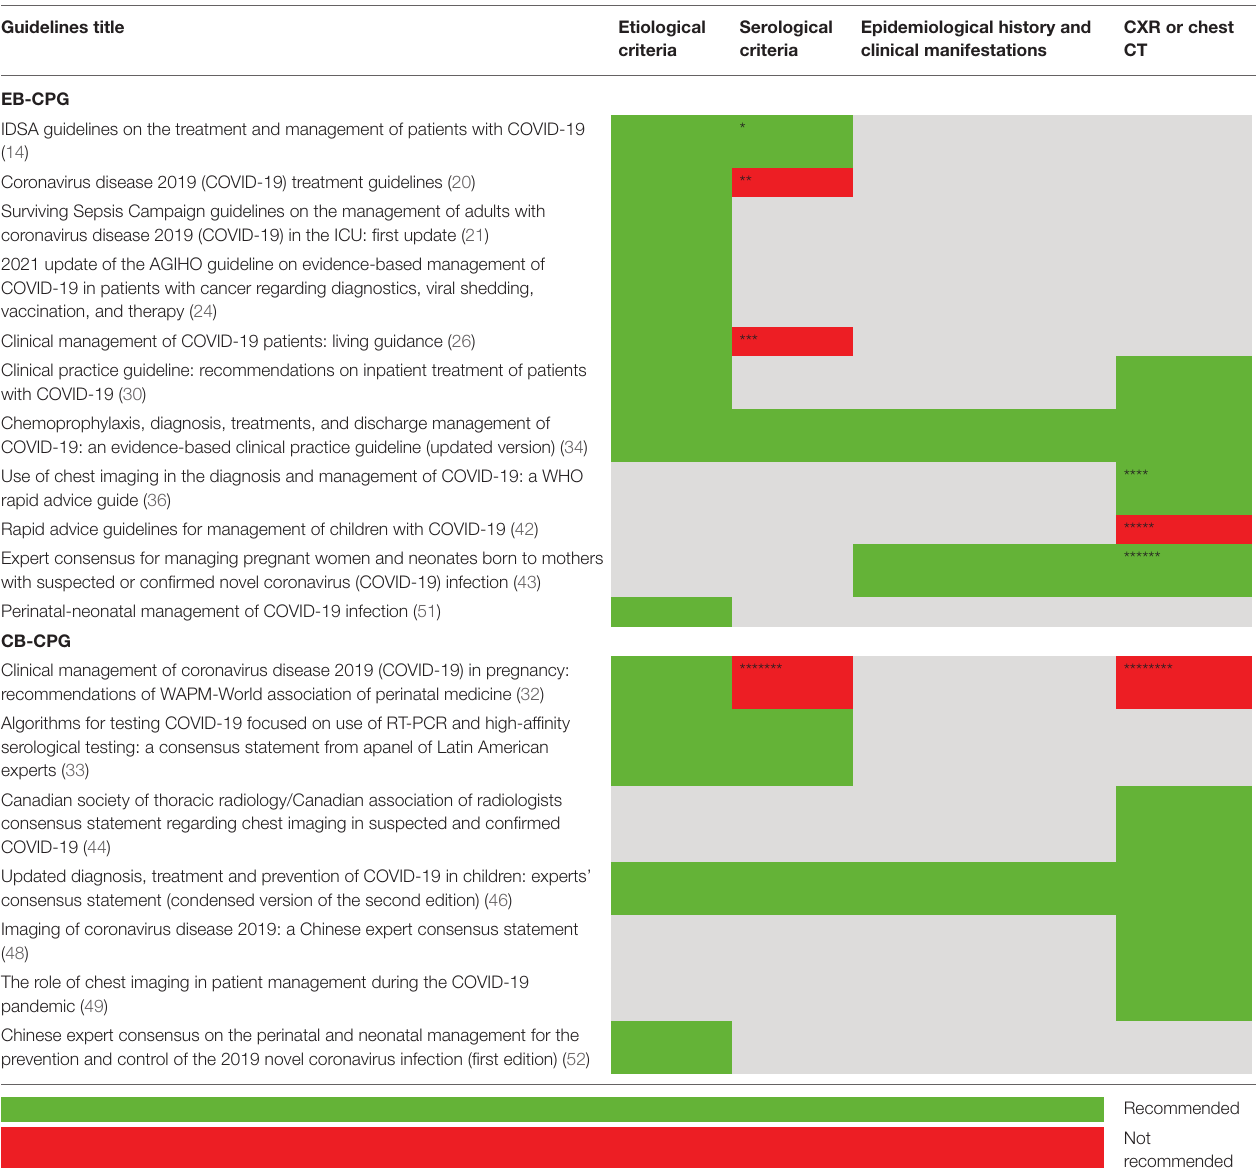
TABLE 3 | Recommendations on diagnosis criteria of